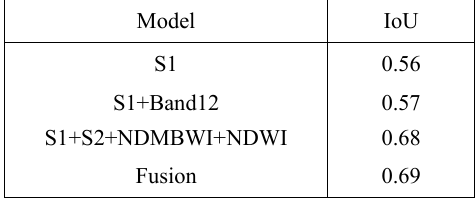
Table 3 . IoUs before and after decision-level data fusion. Besides accuracy assessment, the maps of water extraction are also important to evaluating the decision-level data fusion method. In order to present more characteristics of the decision-level data fusion method, the maps of water extraction should be compared in cloud-free area and cloudarea. Figure 5